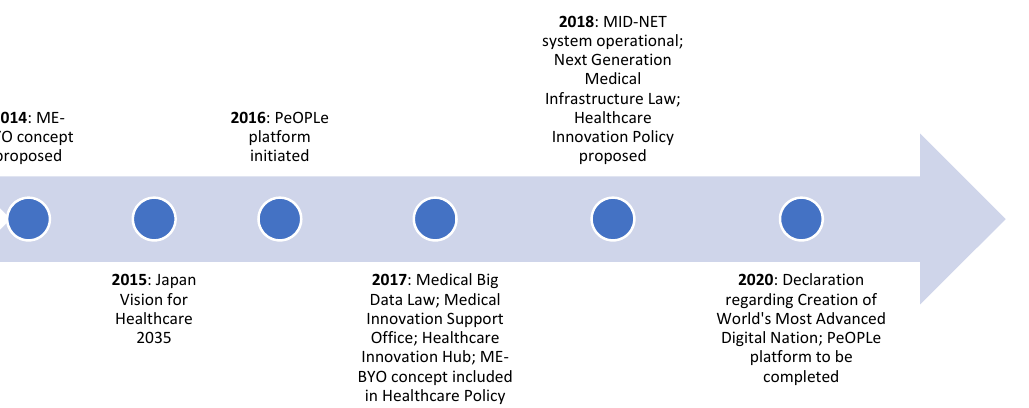
Figure 1. Policy trajectory from cloud adoption to public health innovation in Japan.